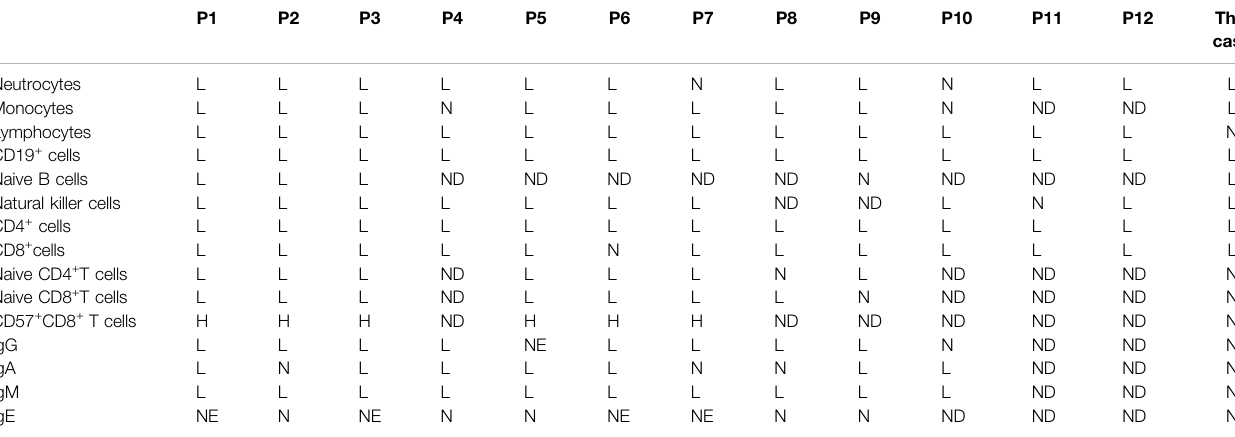
TABLE 2 | The immune associate results of reported X-MAID patients and our